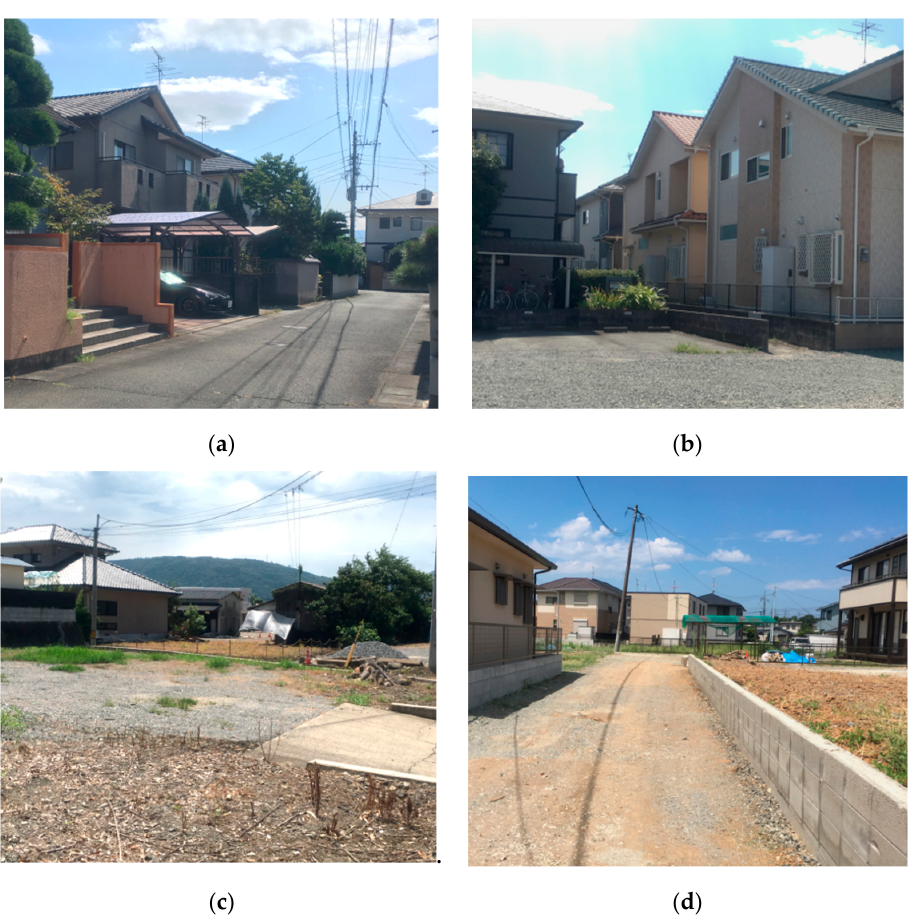
Figure 7. Photos taken at arrow positions ( a – d ) shown in Figure 8. Remote Sens. 2019 , 11 , 2190